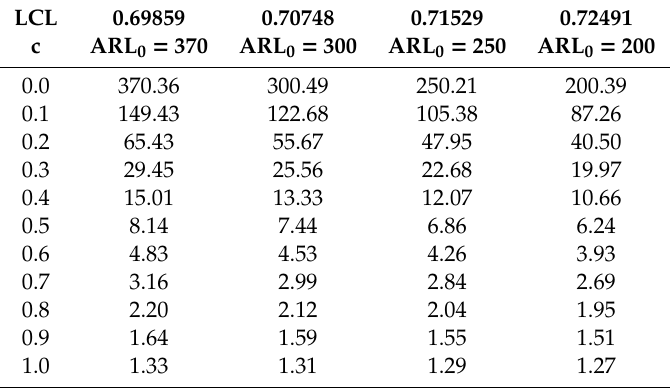
Table 3. The ARLs for the proposed chart when n = 25, WD (1.8,2.0), USL = 5.0504, and LSL =